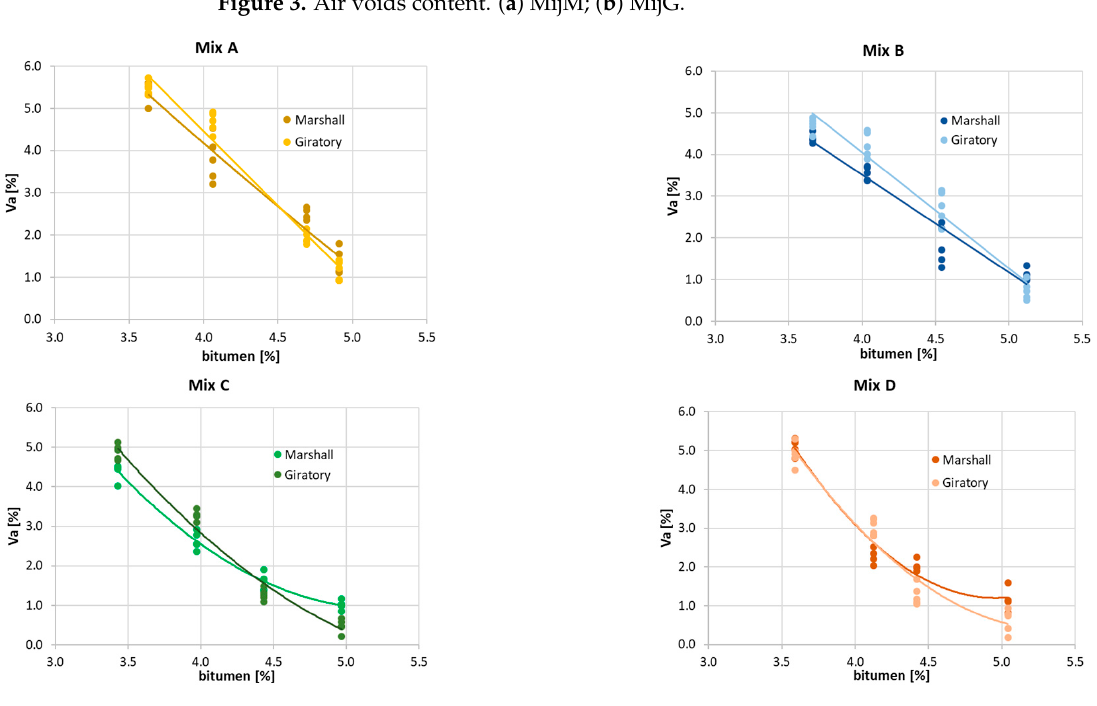
Figure 4. Air voids by the compaction process.